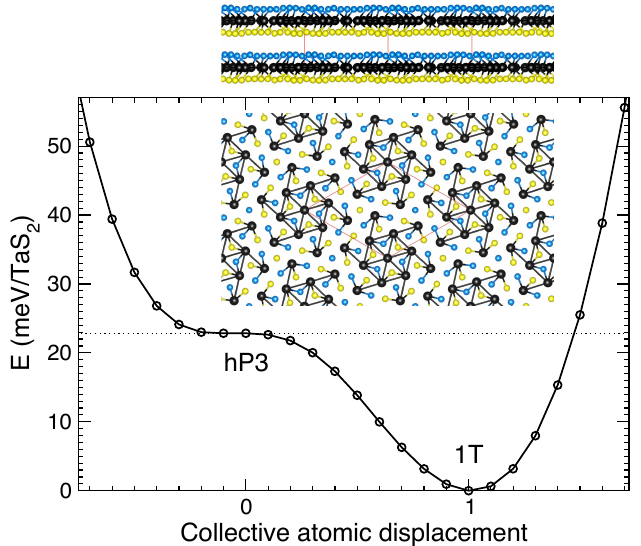
Figure 9. (color online) Enthalpy versus collective atomic displacement in TaS 2 for the linear path between high-symmetry hP3 (at 0) and lower-symmetry 1T (at 1) phases and its continuation. Insets: Relaxed bulk 1T-TaS 2 in 110 (upper) and 001 (lower) projections. S (blue and yellow) is above and below the Ta (black) layer. Bonds shown are Ta–Ta (Ta–S) shorter than 3.28 Å (2.50 Å). The 13(TaS 2 ) hexagonal supercell (thin red lines) with fixed a = 12.233 Å and c = 5.892 Å is composed of 13 hP3 primitive cells ( a = 3.393 Å, c = 5.892 Å); internal atomic relaxation was at fixed supercell lattice